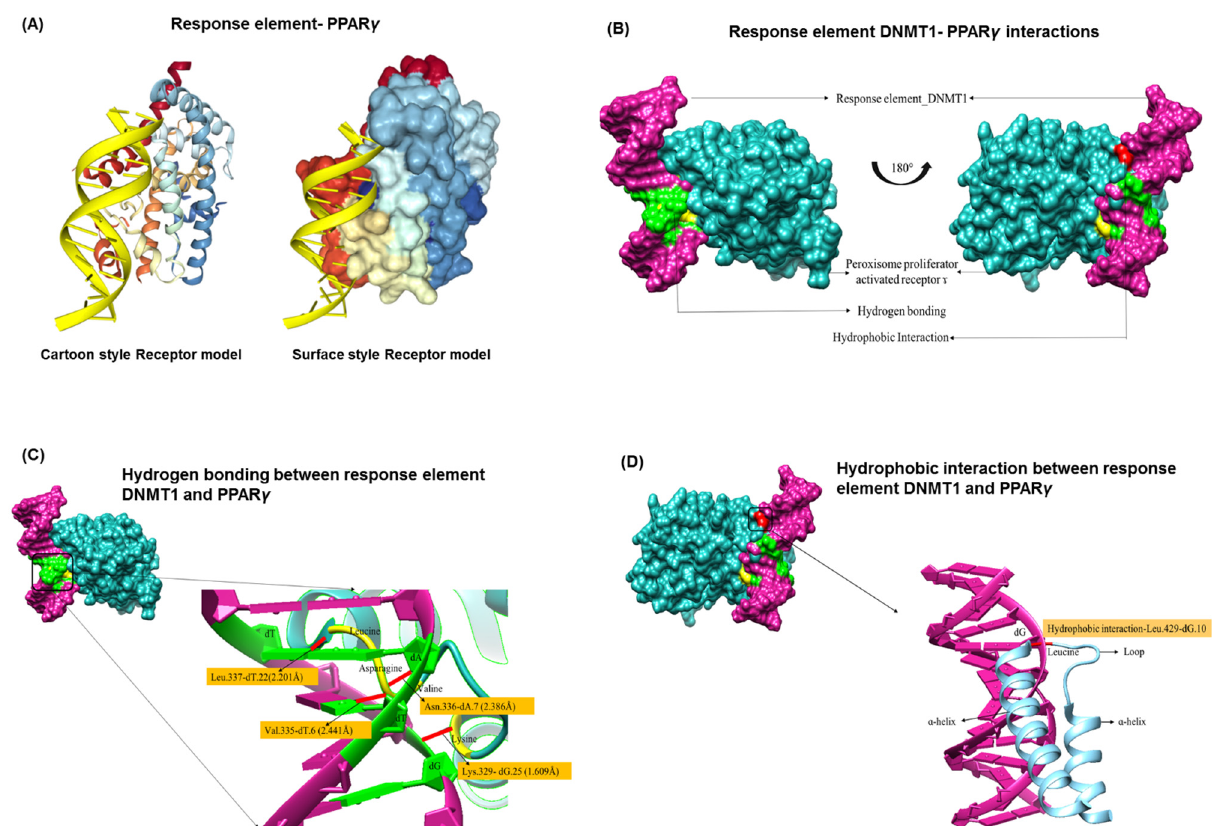
Figure 2. Protein-DNA interactions between PPAR γ and DNMT1 via PPREs. ( A , B ) The highly significant protein-DNA interaction model with specific residues (presented in cartoon style and surface style) interacting with the response element. ( C ) The interaction through the hydrogen bond between dG-25 and Lys at 329th position; dT-6 and Val at 335th position; dA-7 and Asn at 336th position; dT-22 and Leu at 337th position. ( D ) The hydrophobic interaction between dG-10 and Leu residue at 429th position is marked.